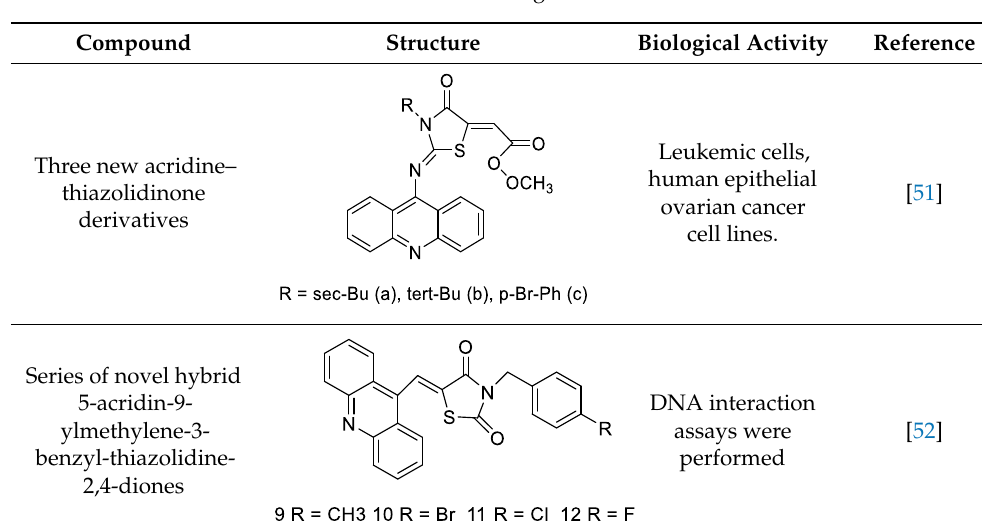
Table 5. Acridine-thiazolidinone as an anti-tumour agent.